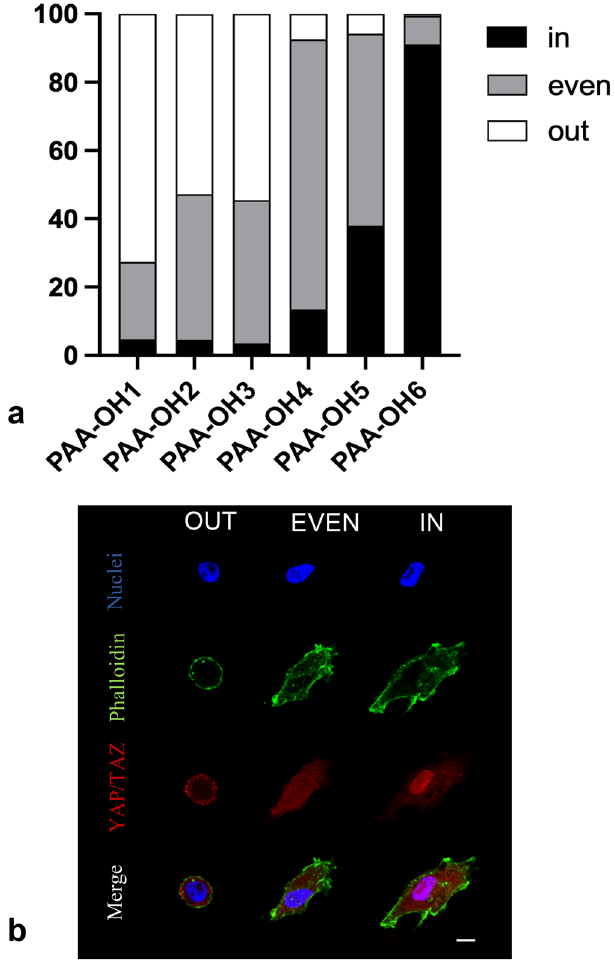
Figure 11. ( a ) Quantifications of the percentage of MFC10A cells displaying nuclear (in), cytoplasmic (out) or even YAP/TAZ subcellular localization, after seeding on the indicated substrates. YAP/TAZ immunofluorescence was performed on MCF10A cells seeded on PAA-OH hydrogels of five different stiffness. YAP/TAZ are nuclear and transcriptionally active in cells experiencing high-rigidities and progressively relocalize to the cytoplasm in cells experiencing more and more compliant substrates 2,32 . ( b ) IF stainings displaying the three different categories of YAP/TAZ localization employed for quantifications; out, YAP/ YAZ staining (in red) is completely excluded from the area of nuclear staining (in blue), even, YAP/YAZ staining is evenly distributed throughout nucleus and cytoplasm, in, YAP/YAZ staining is exclusively co-localized with the nuclear counterstain. F-actin was stained with fluorescently-labeled phalloidin to serve as cell shape reference. Scale bar, 10